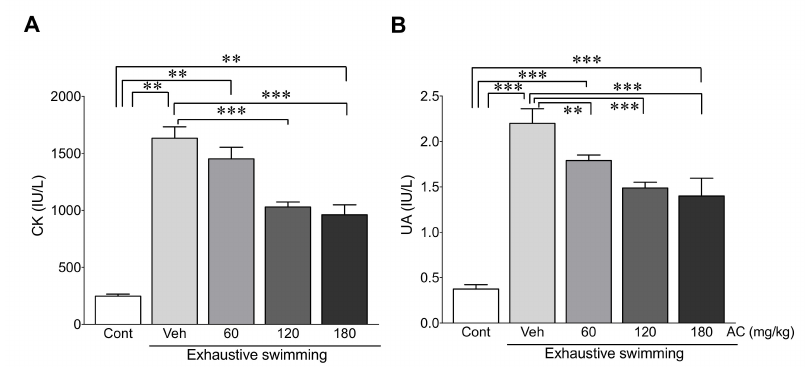
Figure 5. AC extract ameliorated exhaustive swimming-induced muscle injury. The serum levels of ( A ) CK and ( B ) UA were measured in rats after AC pre-treatment for 3 weeks ( n = 10 per group). Data are mean ± standard error of mean (SEM). Significance was measured using one-way analysis of variance (ANOVA) followed by Bonferroni’s post hoc test. ** p < 0.01 and *** p < 0.001. Cont, control; Veh, vehicle-treated; 60, 120, and 180 AC, 60, 120, 180 mg / kg AC extract-treated groups, respectively. AC, Aralia continentalis kitagawa extract; CK, creatine kinase; UA, uric acid.